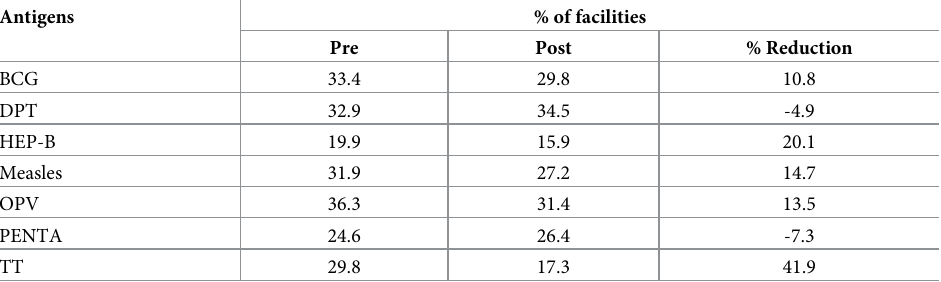
Table 5. Facilities reporting Minimum Stock in Pre- eVIN and Post- eVIN period by antigen.